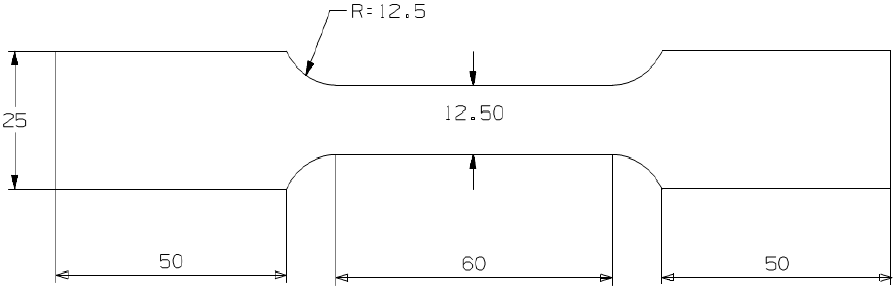
Figure 5. Nominal dimensions of tensile test samples.